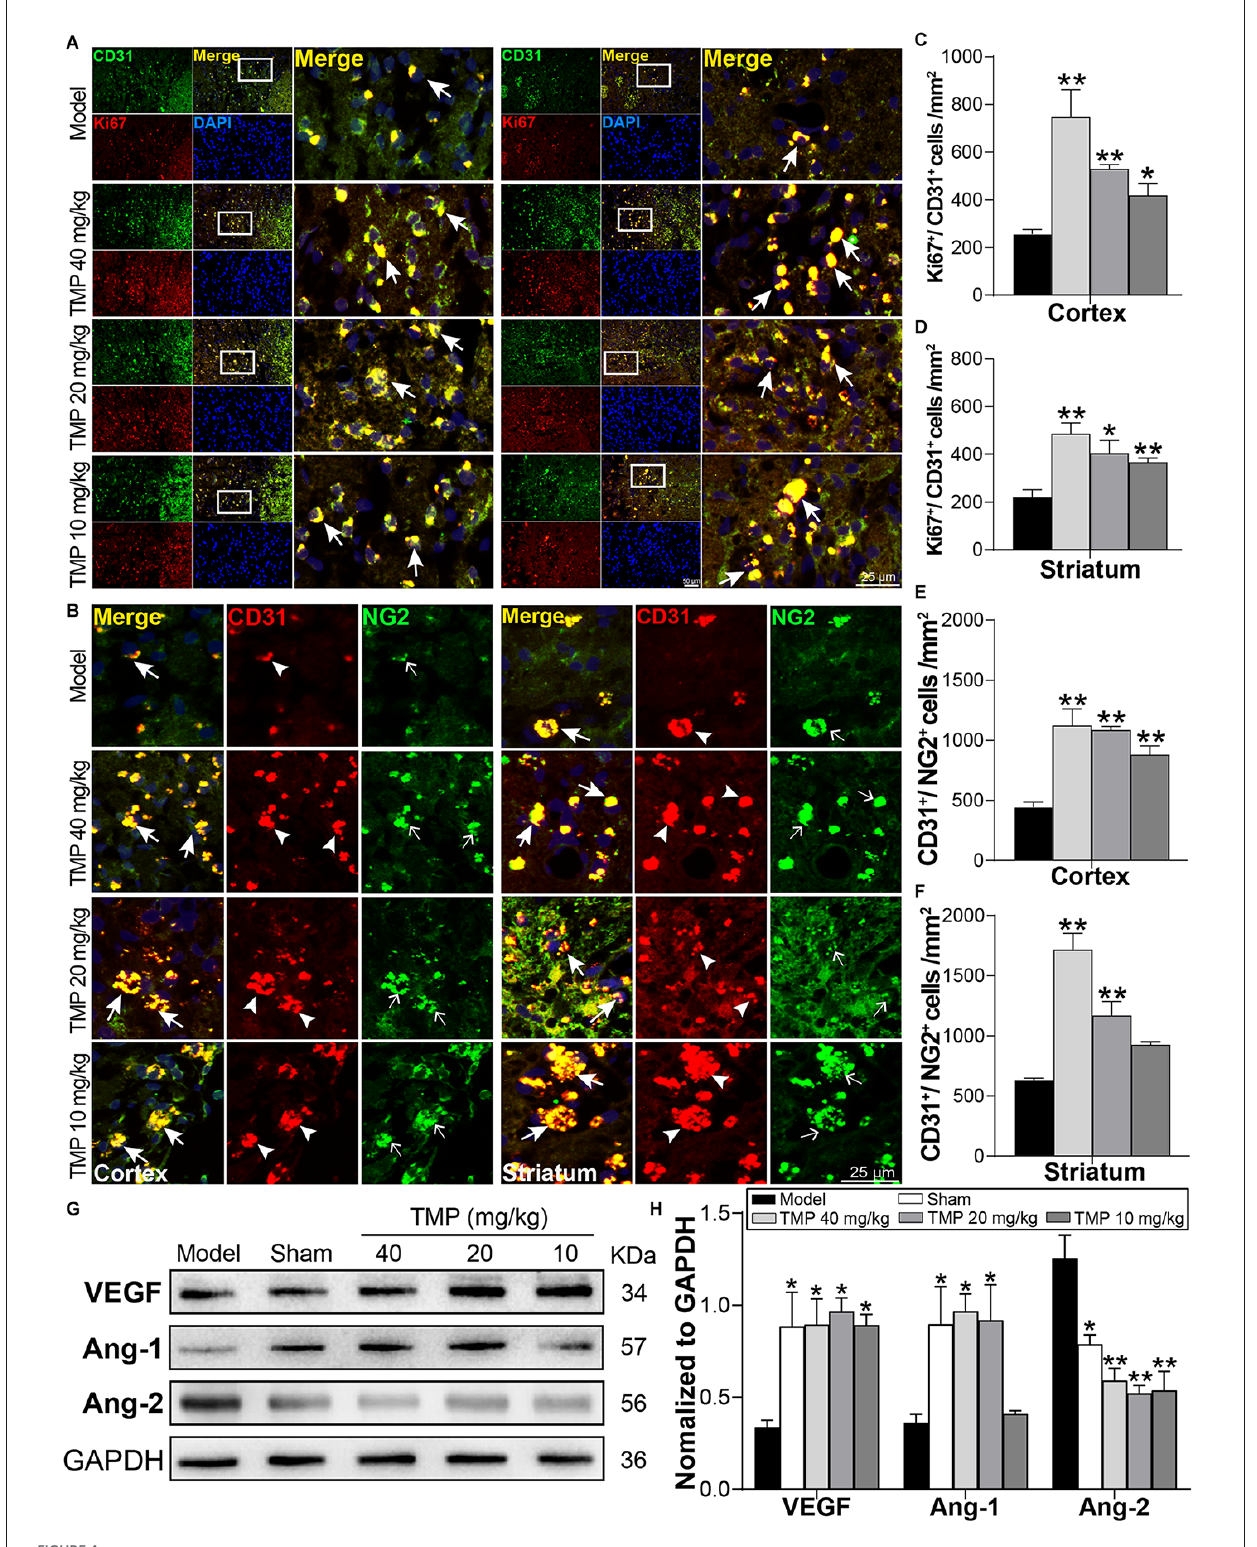
FIGURE4 TMP boosted endogenous angiogenesis of MCAO rats. (A) Immunofluorescence images showed co-localization of CD31-stained endothelial cells (green) and Ki67-stained proliferative cells (red) in peri-infarct cortex and striatum ( n = 4). Merge (yellow) indicated Ki67/CD31 co-labeling cells. (B) Immunofluorescence images showed co-localization of CD31 (red, arrowheads) and NG2-stained pericytes (green, empty arrows) in peri-infarct cortex and striatum ( n = 4). Merge (yellow, arrows) indicated CD31/NG2 co-labeling cells. DAPI (blue) indicated cell nuclei. (C–F) Quantification of Ki67 + /CD31 + and CD31 + /NG2 + cells in peri-infarct cortex and striatum of Model and TMP groups. (G,H) Western blot analysis for VEGF, Ang-1, and Ang-2 in the periinfarct cortex ( n = 4). * P < 0.05, ** P < 0.01 vs. Model